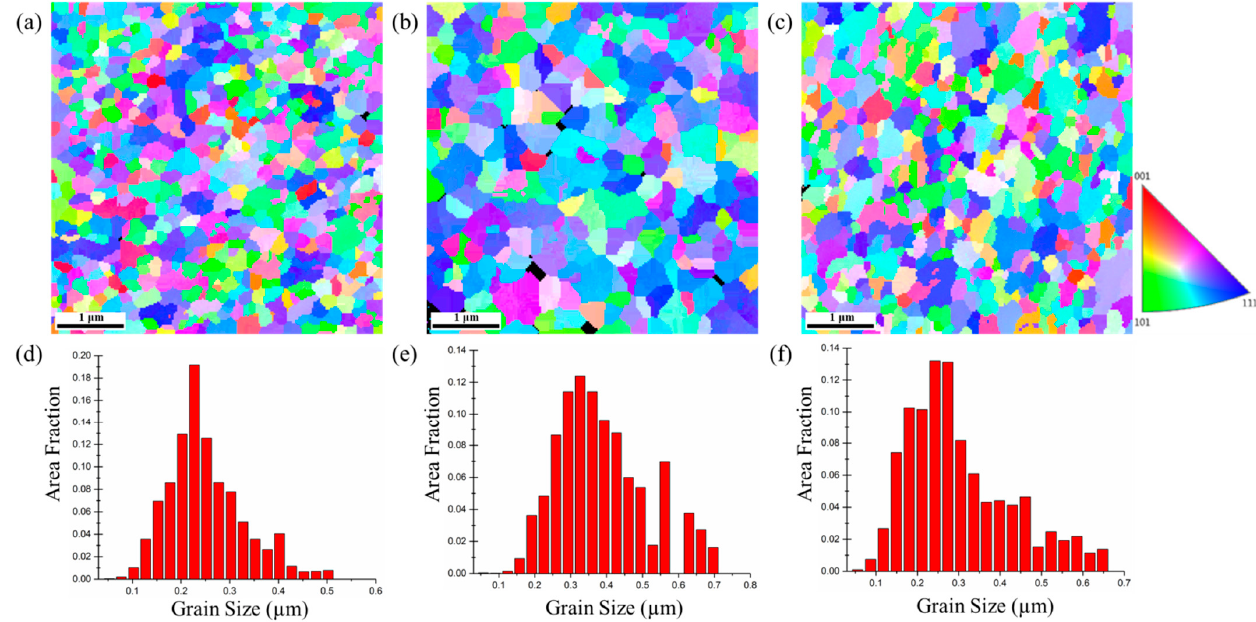
Figure 5. Plan-view EBSD micrographs and grain size distributions of the 5- µ m thick nt-Cu foils electroplated with different concentrations of Cu 2+ : ( a , d ) 0.3 M; ( b , e ) 0.5 M; ( c , f ) 0.8 M,